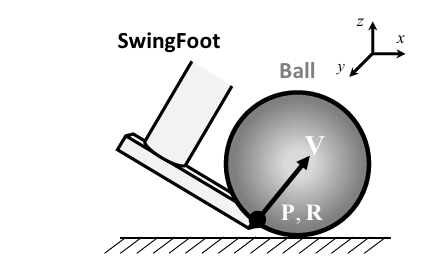
Figure 2. At the moment when a humanoid robot kicks a ball, position P , pos- ture R and velocity V are constrained for accomplishing a kicking task.